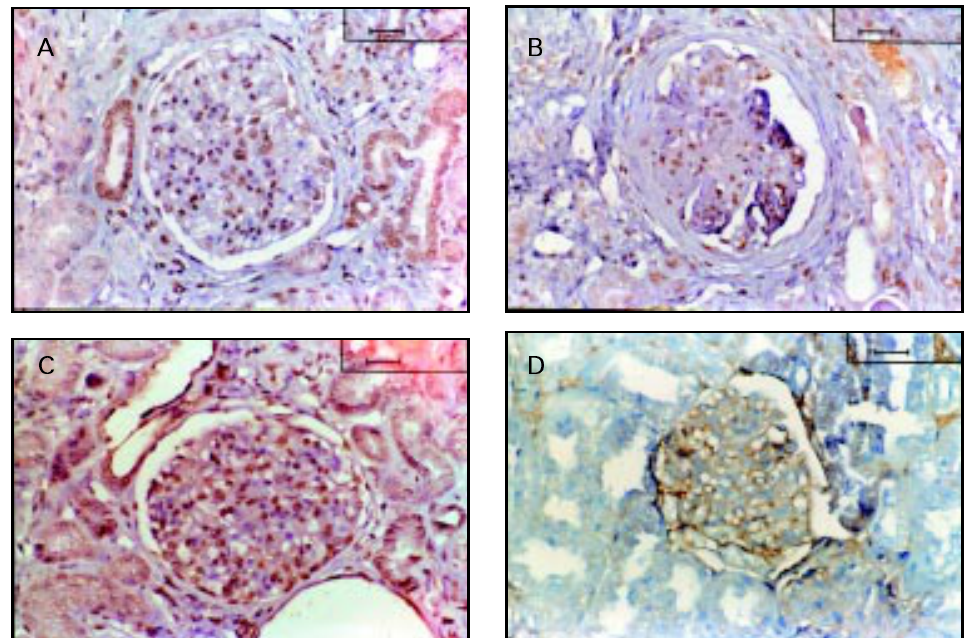
Figure 1 - Detection of T cells, Leishmania antigen and immu- noglobulin in glomerular lesions in canine visceral leishmaniasis by immunoperoxidase